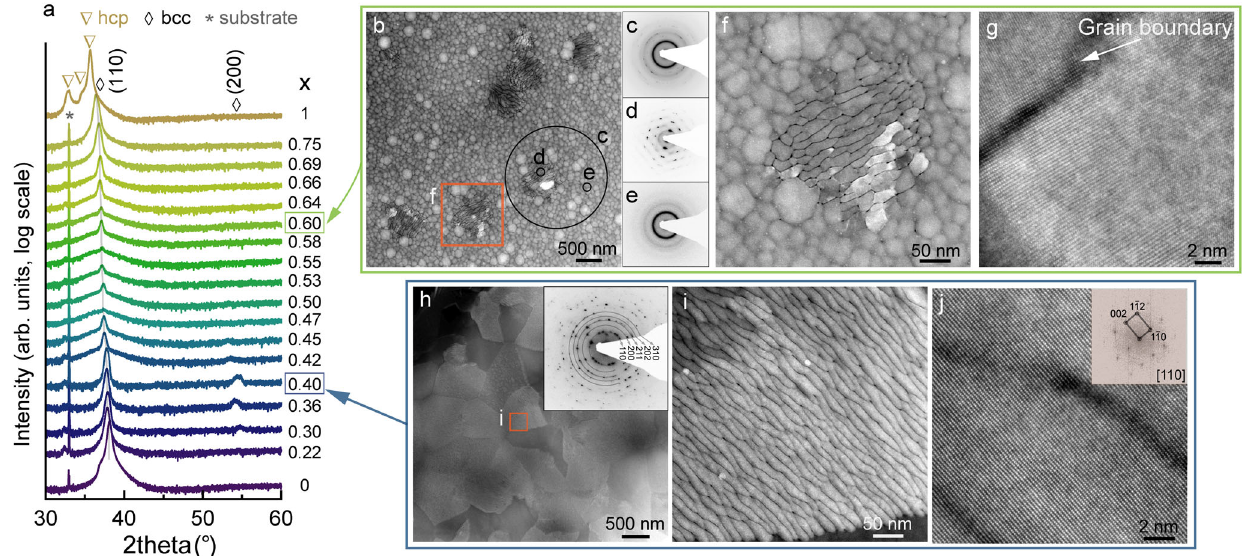
Fig. 1 Microstructure of the (TaNb) 1 − x (ZrHfTi) x fi lms. a θ − 2 θ X-ray diffractograms of the (TaNb) 1 − x (ZrHfTi) x fi lms deposited on Si (100) substrate as a function of x , from 0 to 1. b HAADF-STEM images of (TaNb) 0.4 (ZrHfTi) 0.6 , revealing a crystal/glass nanocomposite structure. c SAED pattern from the corresponding circled area in b . d , e SAED patterns from the corresponding circled regions in b , respectively. f Magni fi ed view from b . g HAADF-STEM image of crystalline region. h – j , HAADF-STEM images of (TaNb) 0.6 (ZrHfTi) 0.4 , showing a crystalline microstructure. The inset on top of h shows the SAED pattern from selected area in h . i Higher magni fi cation of the boxed area in h . f Lattice resolved HAADF-STEM image. The inset is the corresponding fast Fourier transform (FFT) image, showing a bcc phase structure with <110> zone axis.